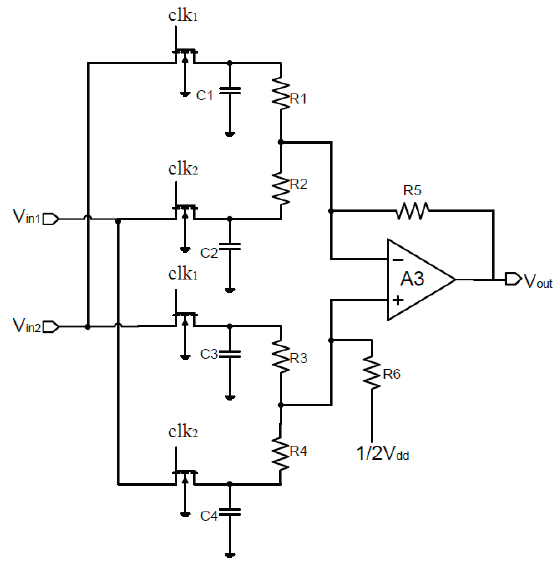
Figure 7. Demodulation circuit with sample/hold and adding functions.